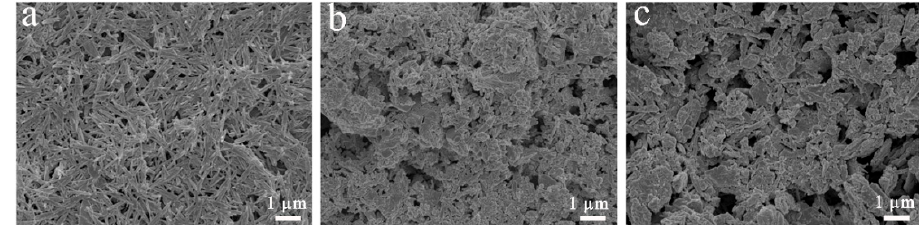
Figure 5. SEM images of ( a ) PAL, ( b ) ZnO/PAL, and ( c ) CAR/ZnO/PAL.